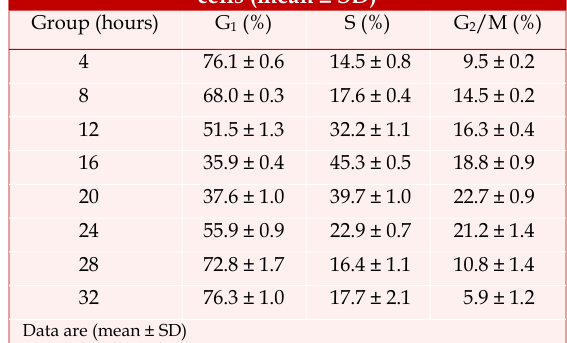
Cell cycle progress after desynchronization of